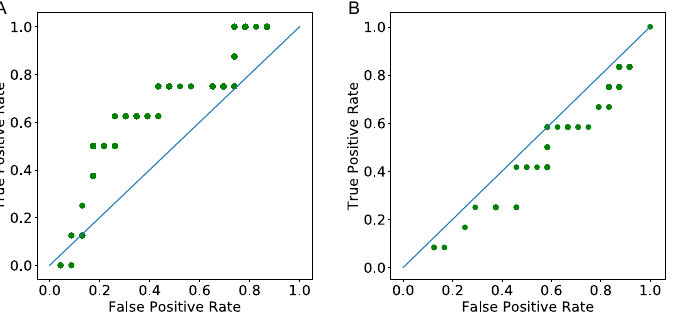
Figure 6. ROC Curves of the model. ( A , B ) are generated using predicted cancer cells number in the first day of follow up and the last day of follow up of the patients , and AUC values are 0.53 and 0.41,